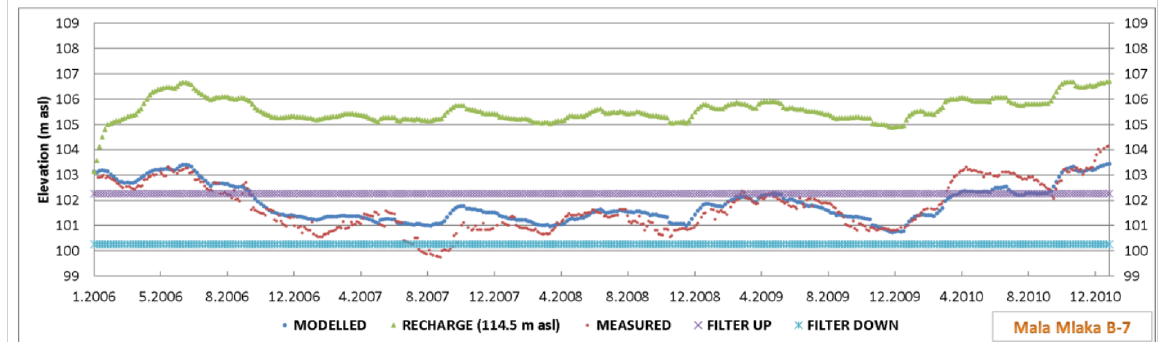
Figure 16. Influence of the MAR variant with a water level of 114.5 m a.s.l. on well B-7 of the Mala Mlaka water pumping